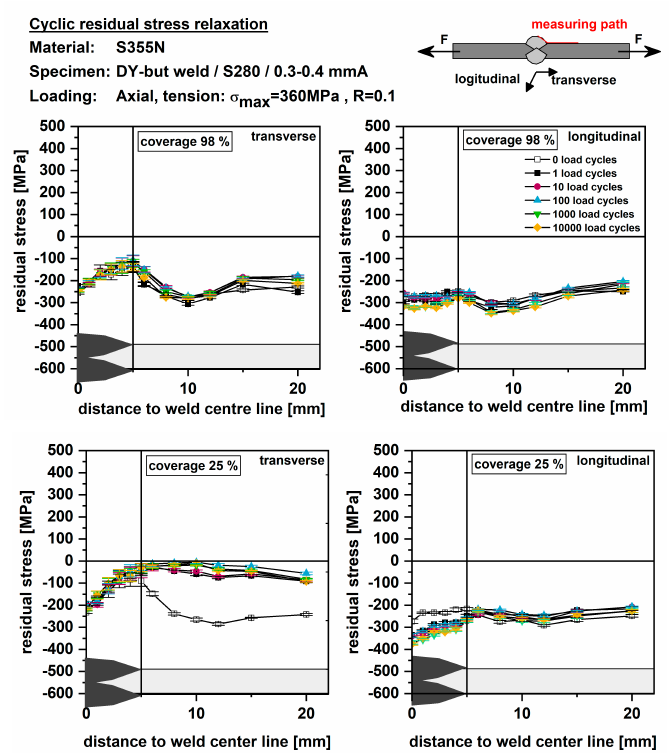
Figure 5. Residual stress relaxation in shot peened DV-butt welds. Use of steel shots at constant intensity. Variation of the coverage of 98% ( top ) and 25% ( bottom ). Cyclic loading at R = 0.1 with maximum stress of 360 MPa.